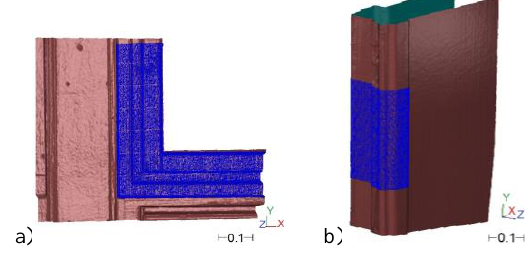
Figure 5. Mesh and corresponding segmented point cloud (dark blue) of window frame (a), and door jamb (b)